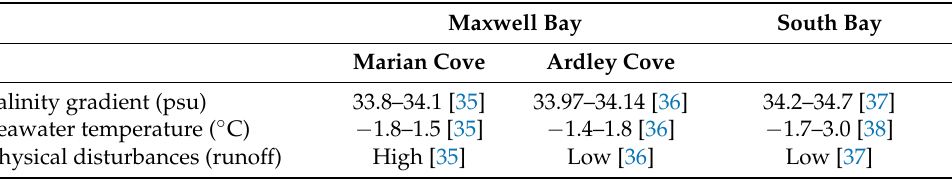
Table 1. Details of study sites. Salinity and seawater temperature gradient refer to surface waters (<10 m depth) throughout the